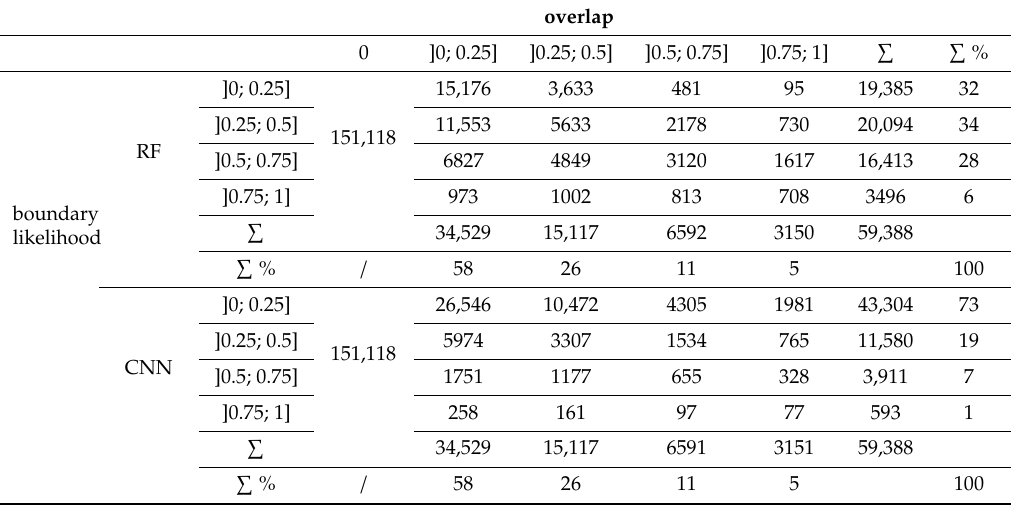
Table 5. How correct is the predicted boundary